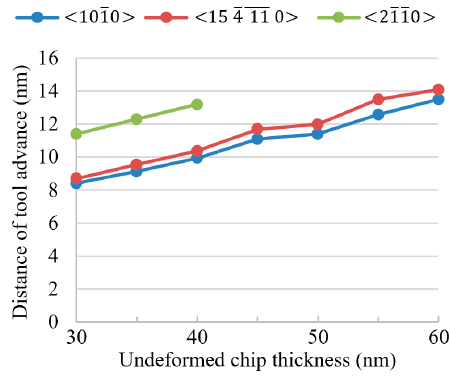
Figure 8. Distance of tool advancement to induce the required compressive stress.